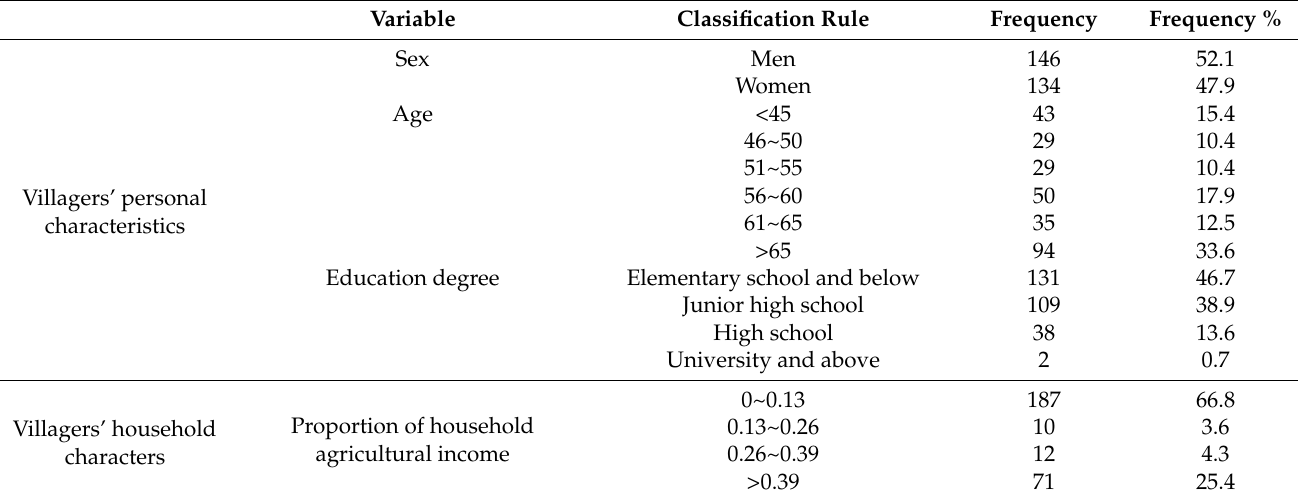
Table 3. Descriptive statistics of the sampled villagers ( n =